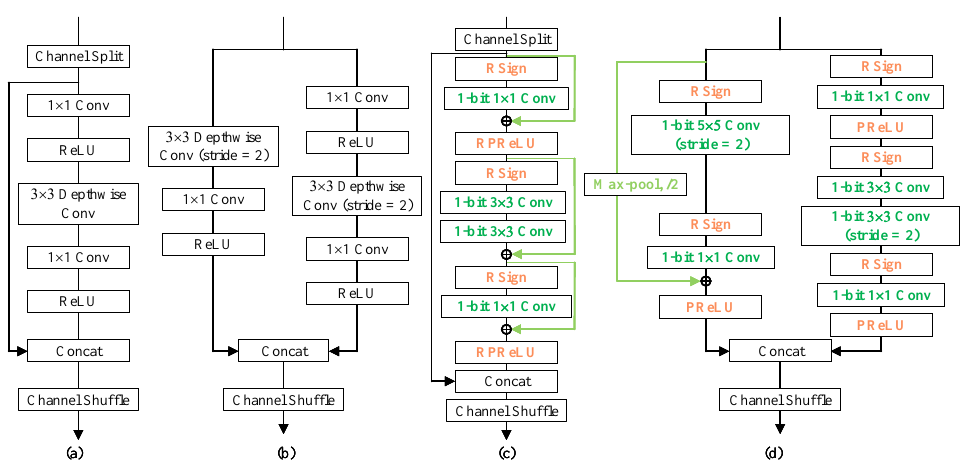
Figure 2. Building units of ShuffleNet V2 ( a , b ) and Bi-ShuffleNet ( c , d ). For the sake of brevity, the batch normalization layer after each convolution layer is